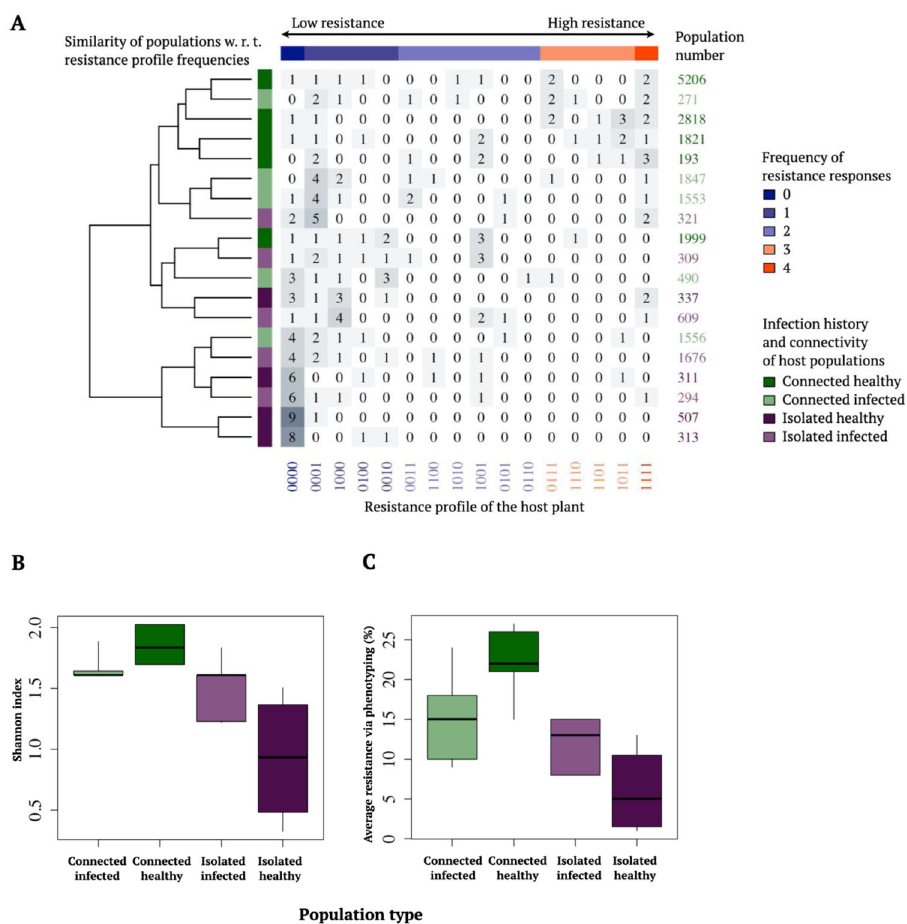
Fig.2|Resistanceof Plantagolanceolata populationsdependsonconnectivity ( S H ) and disease history. The phenotype composition of the19 study populations was de fi ned by individual plant ( n =10 per population) responses to the four pathogenstrains,resultinginatotalof N =190observationsvisualizedinpanel( A ). The matrix of detected resistance phenotypes in the inoculation study shows clusteringofsimilarphenotypicpro fi lesdetectedinpopulationsineachofthefour connectivity ( S H ) – infection history categories. The columns of the matrix corre- spond to resistance phenotypes, where the i ’ th element of the vector is 1, if resis- tancetopathogenstrainIwasdetected,andzerootherwise.Therowsofthematrix encode the observed frequencies of resistance phenotypes within the studied populations. The dendrogram visualizes the similarity structure between the